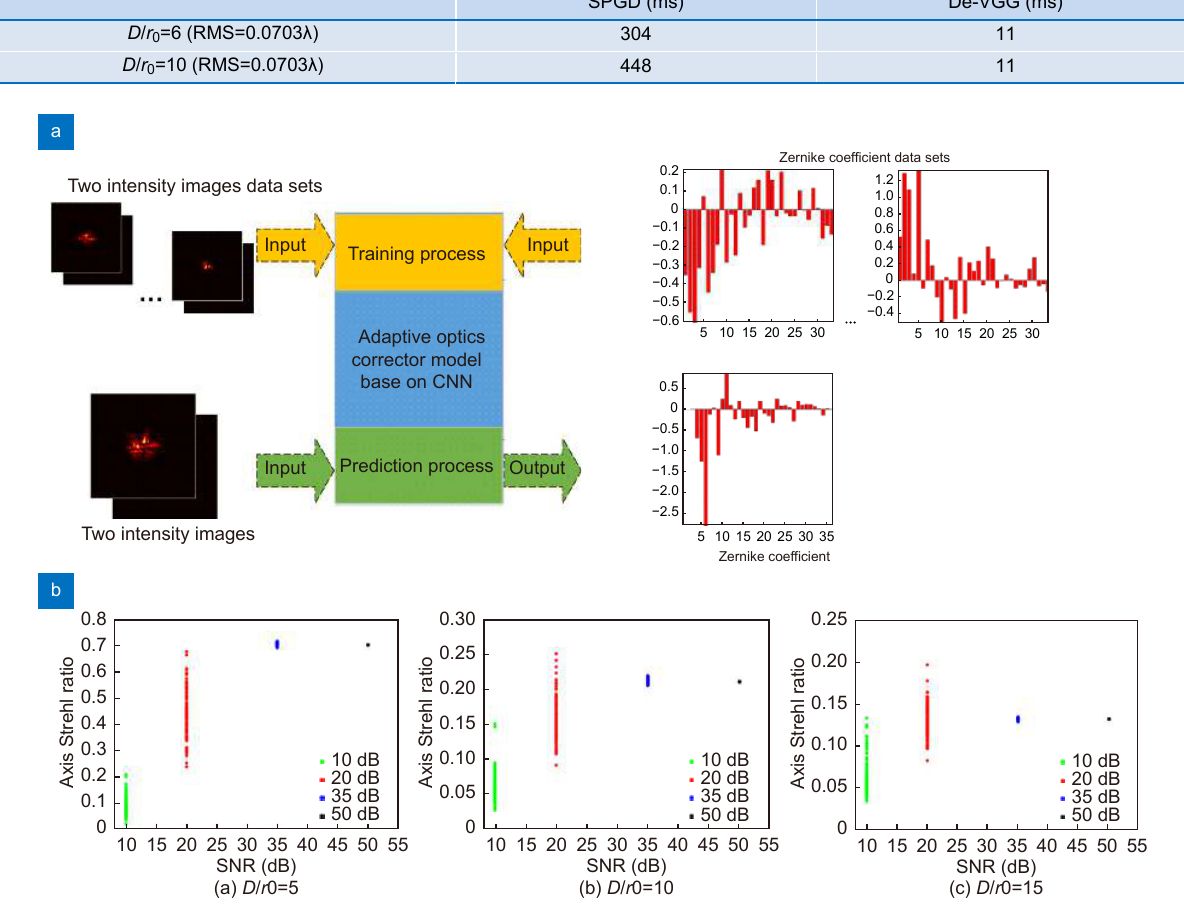
Fig. 10 | ( a ) The data flow of the training and inference processes. ( b ) Strehl ratio of CNN compensation under different SNR conditions. Figure reproduced with permission from: (a, b) ref. 81 ,